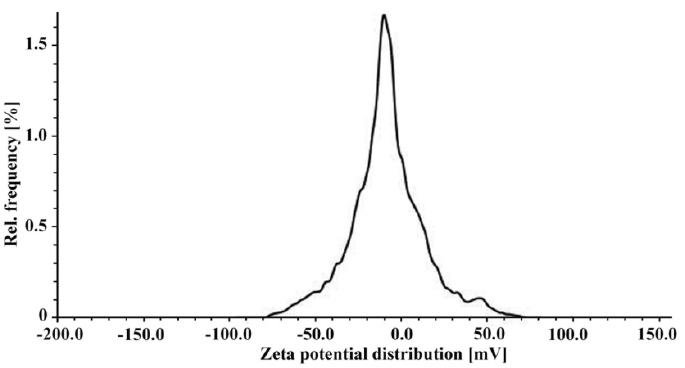
Figure 5. ( a ) HR-TEM images, ( b ) particle size distribution histogram of N-ZnOPs, and( c ) SAED pattern of N-ZnO Ps.